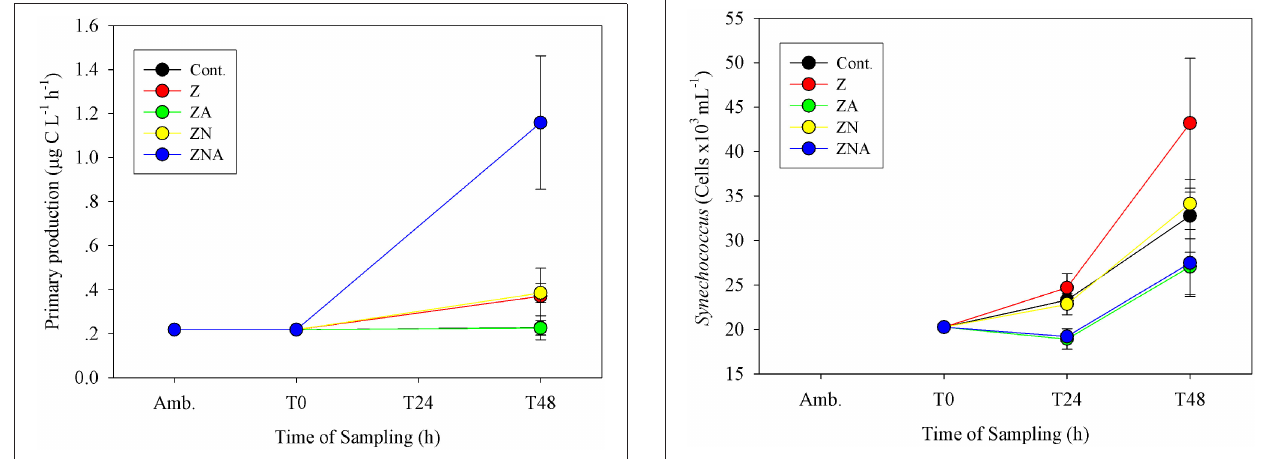
FIGURE 3 | Measured changes in primary productivity rate in the microcosm treatments compared with the initial ambient values of the water used to inoculate the microcosm bottles.